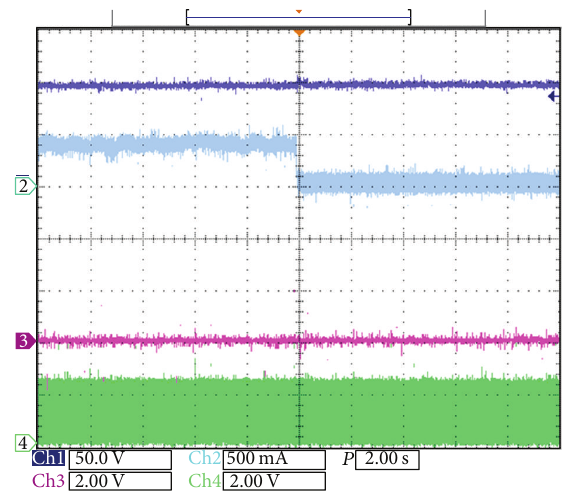
Figure 16: Operation when suddenly the maximum power energy of the renewable source becomes lower than the output power from , 𝑆 2 , and 𝑆 1 . top to bottom 𝑉 𝑜 , −𝐼 𝐿 2